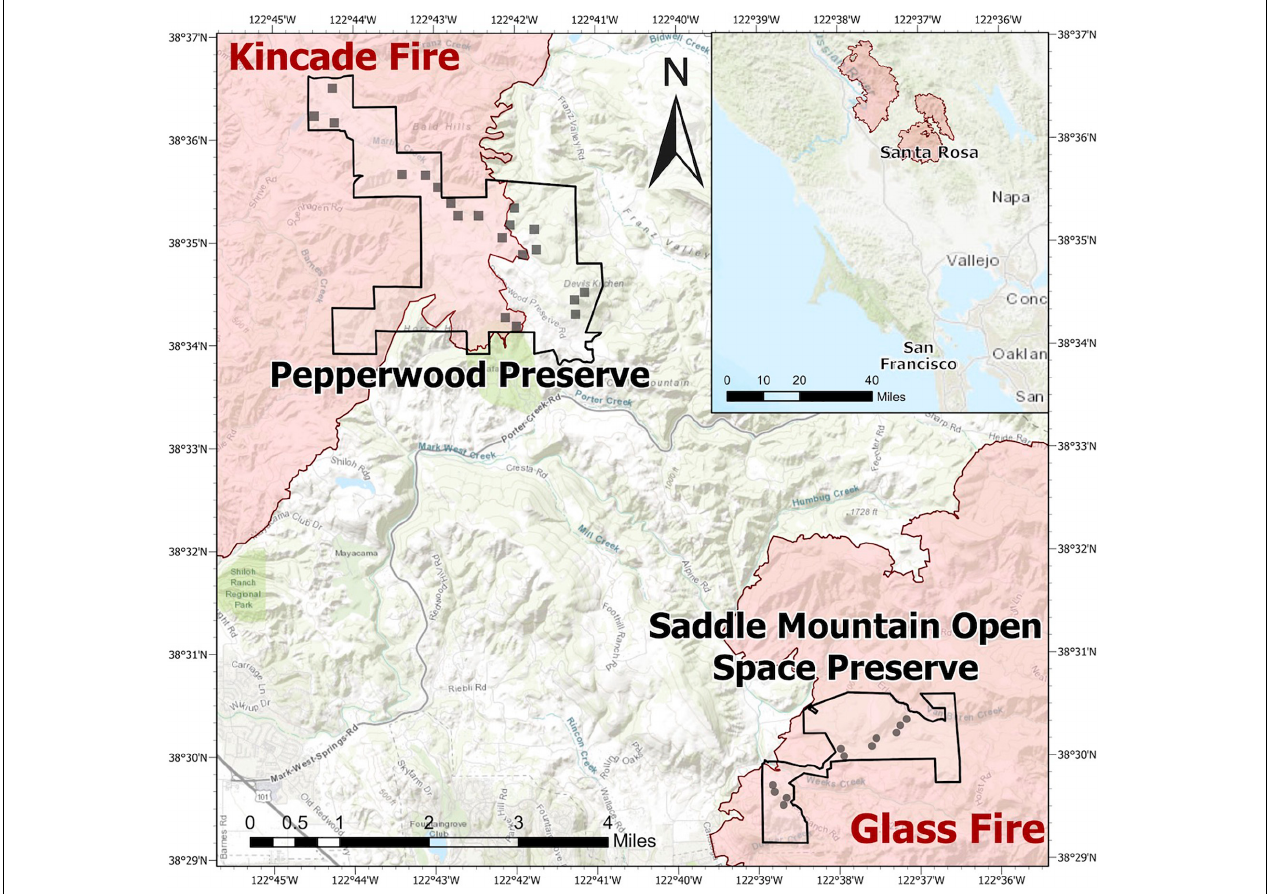
FIGURE 1 | Map of our study locations (Pepperwood Preserve and Saddle Mountain Open Space Preserve) and plots (indicated by gray squares and circles) in Sonoma County, California. The perimeter of each wildfire that occurred during our research study is shown in